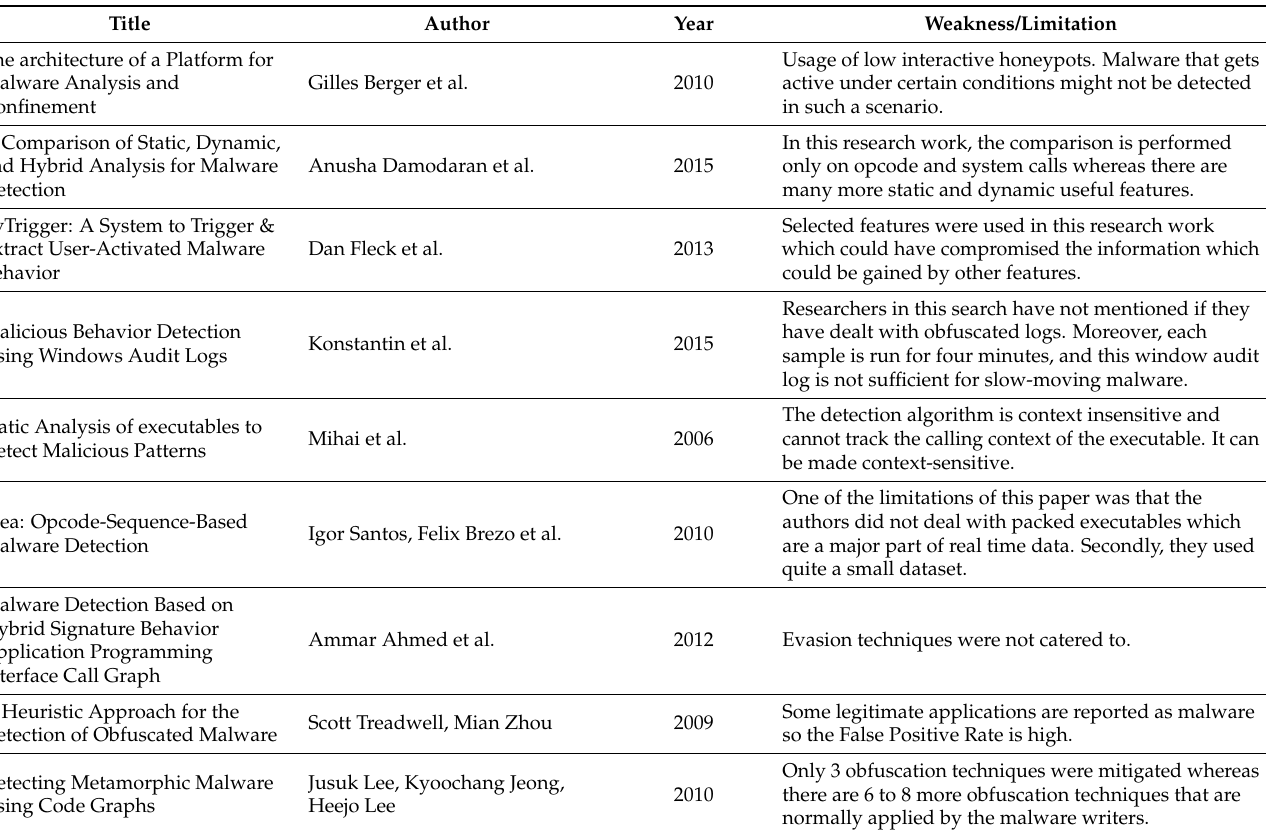
Table 4. Limitations of Surveyed Papers Proposing Primitive Methods for Malware